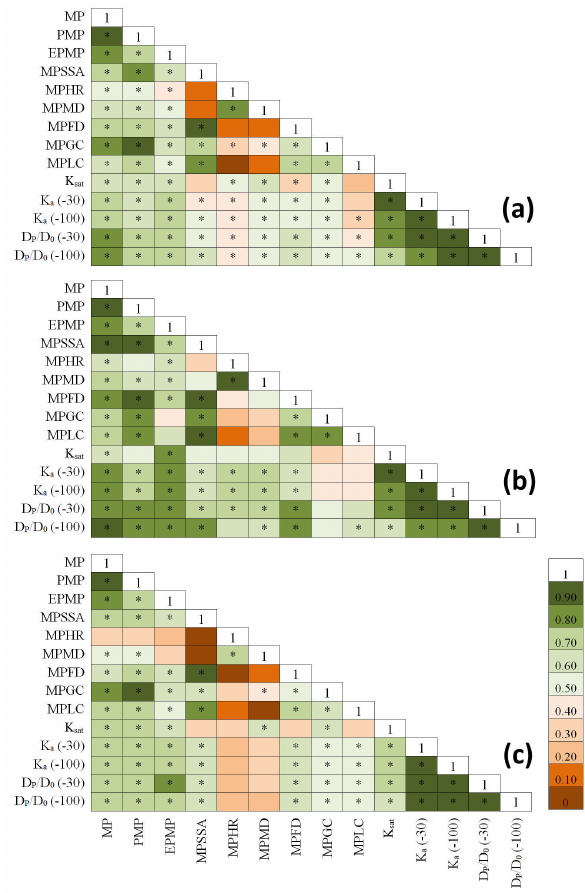
Figure 7. Spearman rank order correlation analysis for (a) all sam- ples ( n = 65), (b) samples with biopore flow ( n = 16), and (c) sam- ples with matrix flow ( n = 49); stars indicate significant correlations at p value<0.01. MP is macroporosity, PMP is percolating macro- porosity, EPMP is effective percolating macroporosity, MPSSA is macropore specific surface area, MPHR is macropore hydraulic ra- dius, MPMD is macropore mean diameter, MPFD is macropore fractal dimension, MPGC is macropore global connectivity, MPLC is macropore local connectivity, K sat is saturated hydraulic conduc- tivity (cmh − 1 ) , K a − 30 is air permeability (µm 2 ) at − 30cm ma- tric potential, K a − 100 is air permeability (µm 2 ) at − 100cm ma- tric potential, D P /D 0 − 30 is gas diffusivity at − 30cm matric po- tential, and D P /D 0 − 100 is gas diffusivity at − 100cm matric po- tential. Strong correlation ( r >0.70), moderate correlation ( r = 0.5– 0.7), and weak correlation ( r